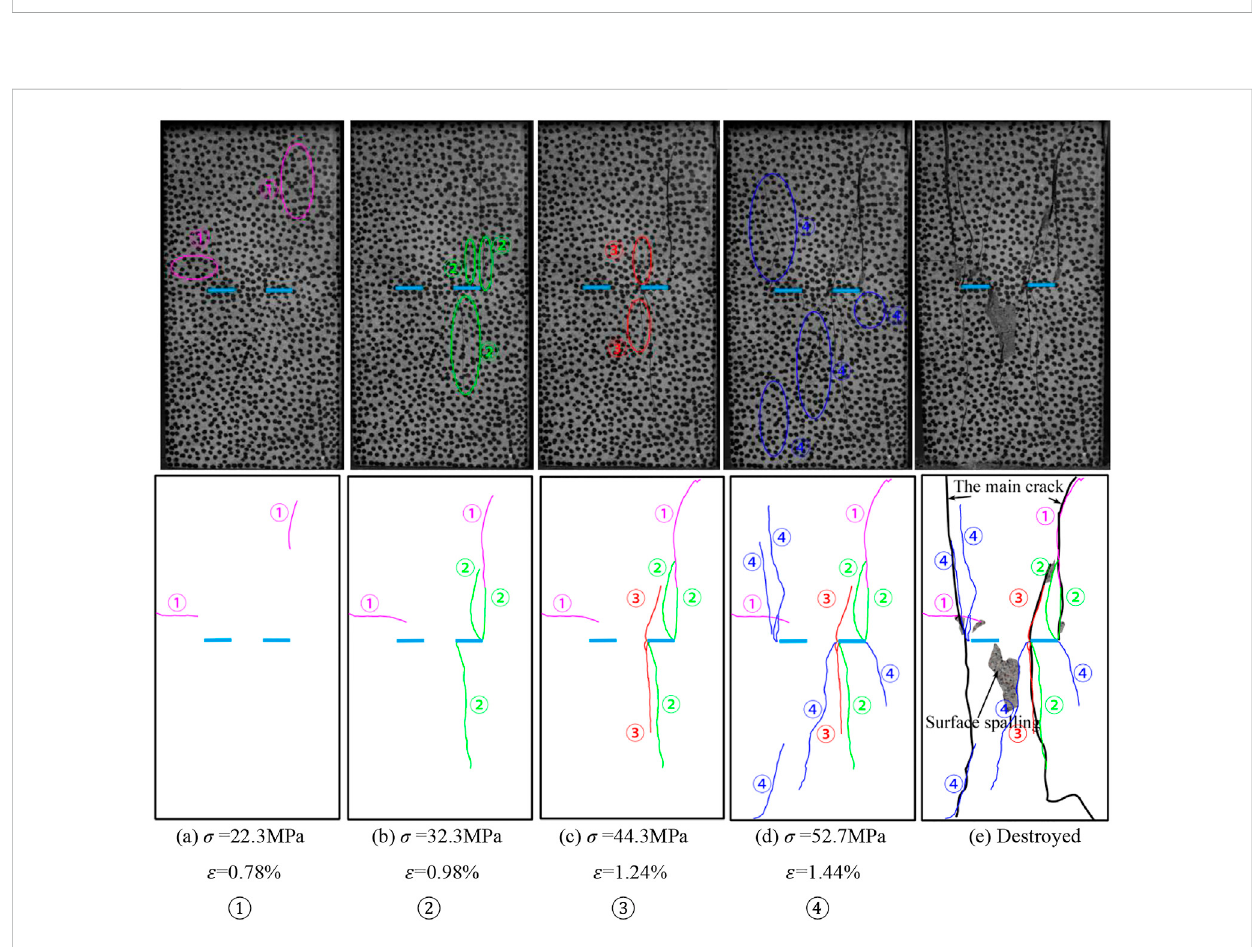
FIGURE 8 Crack propagation and failure of rock samples with α = 0 ° and 2b = 14